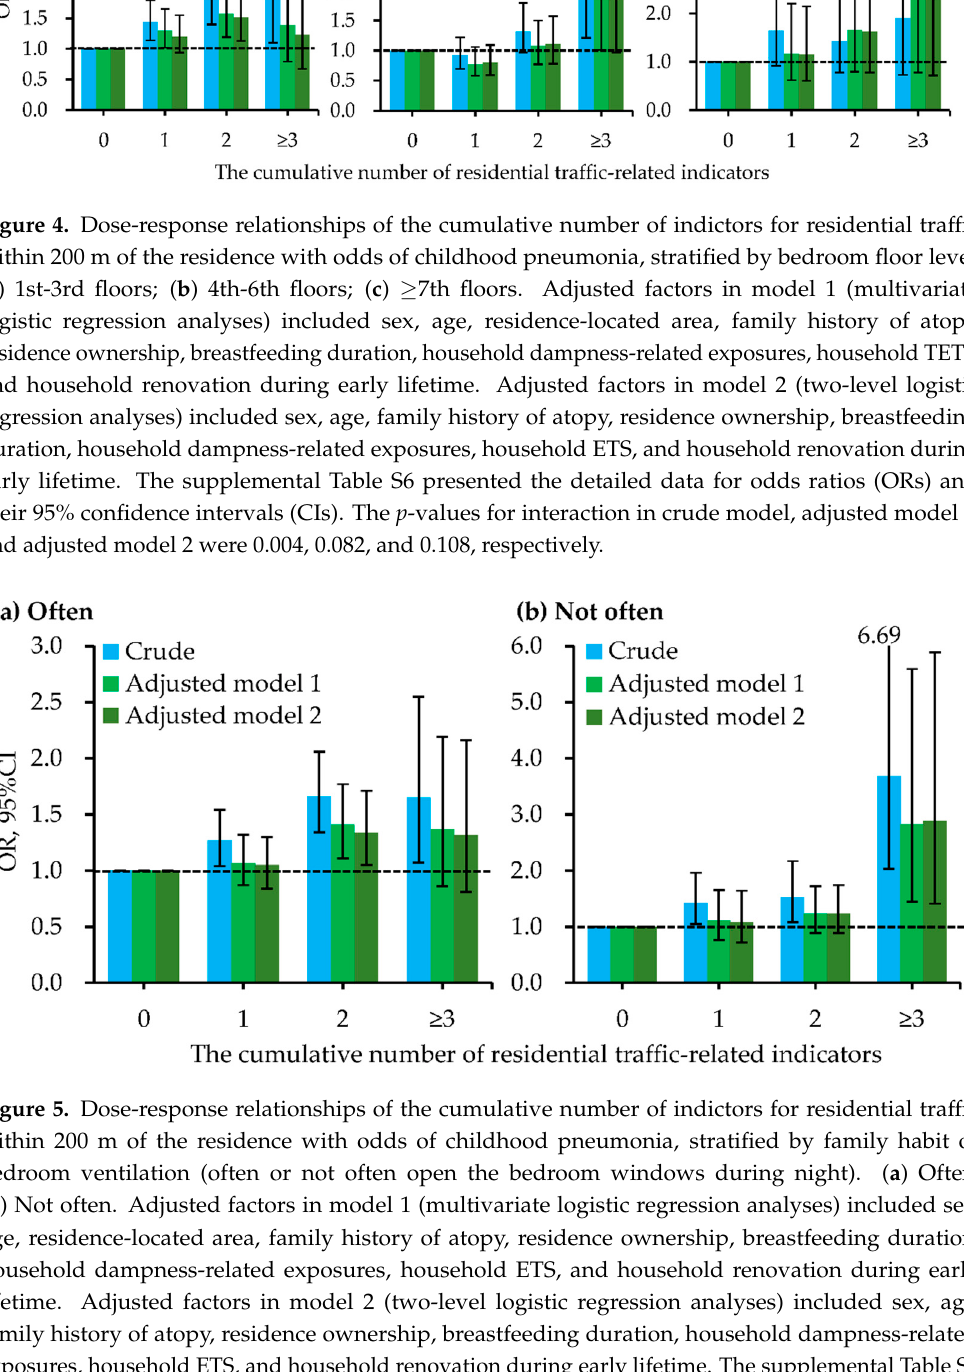
for interaction in crude model, adjusted model 1, and adjusted model 2 were 0.001, 0.065, and 0.051,